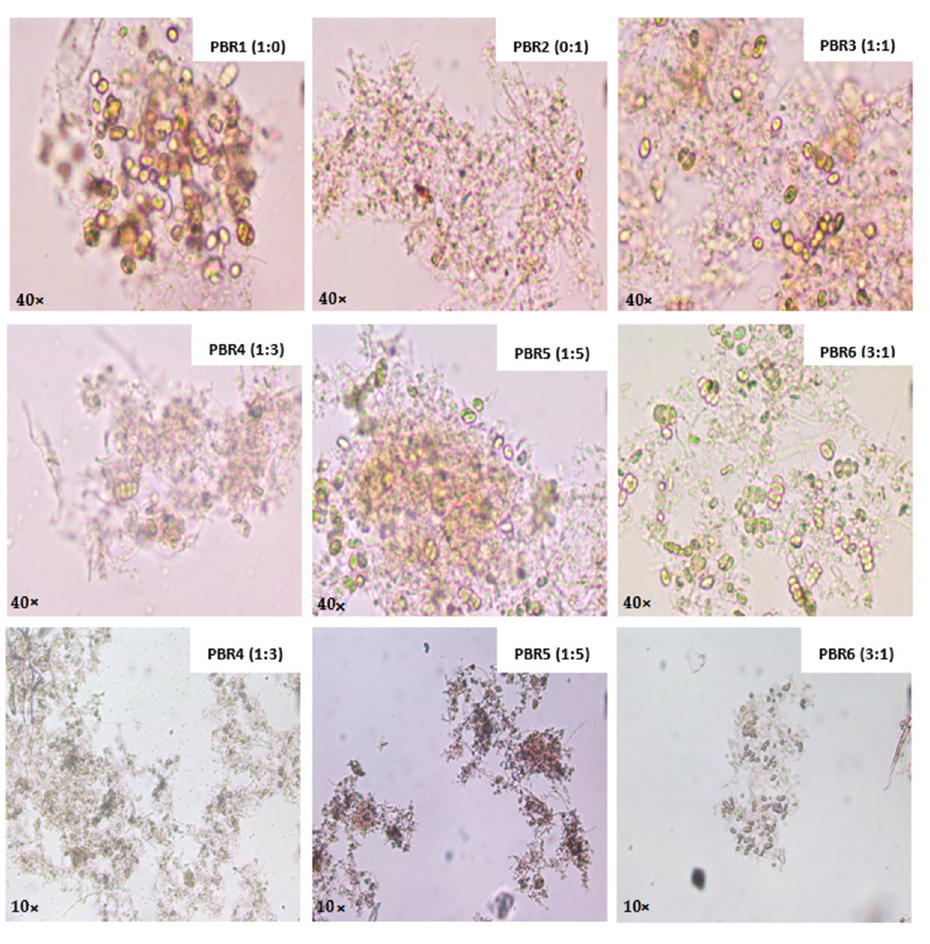
Figure 6. Microalgae–bacteria consortia in photobioreactors after 14 days of operation.